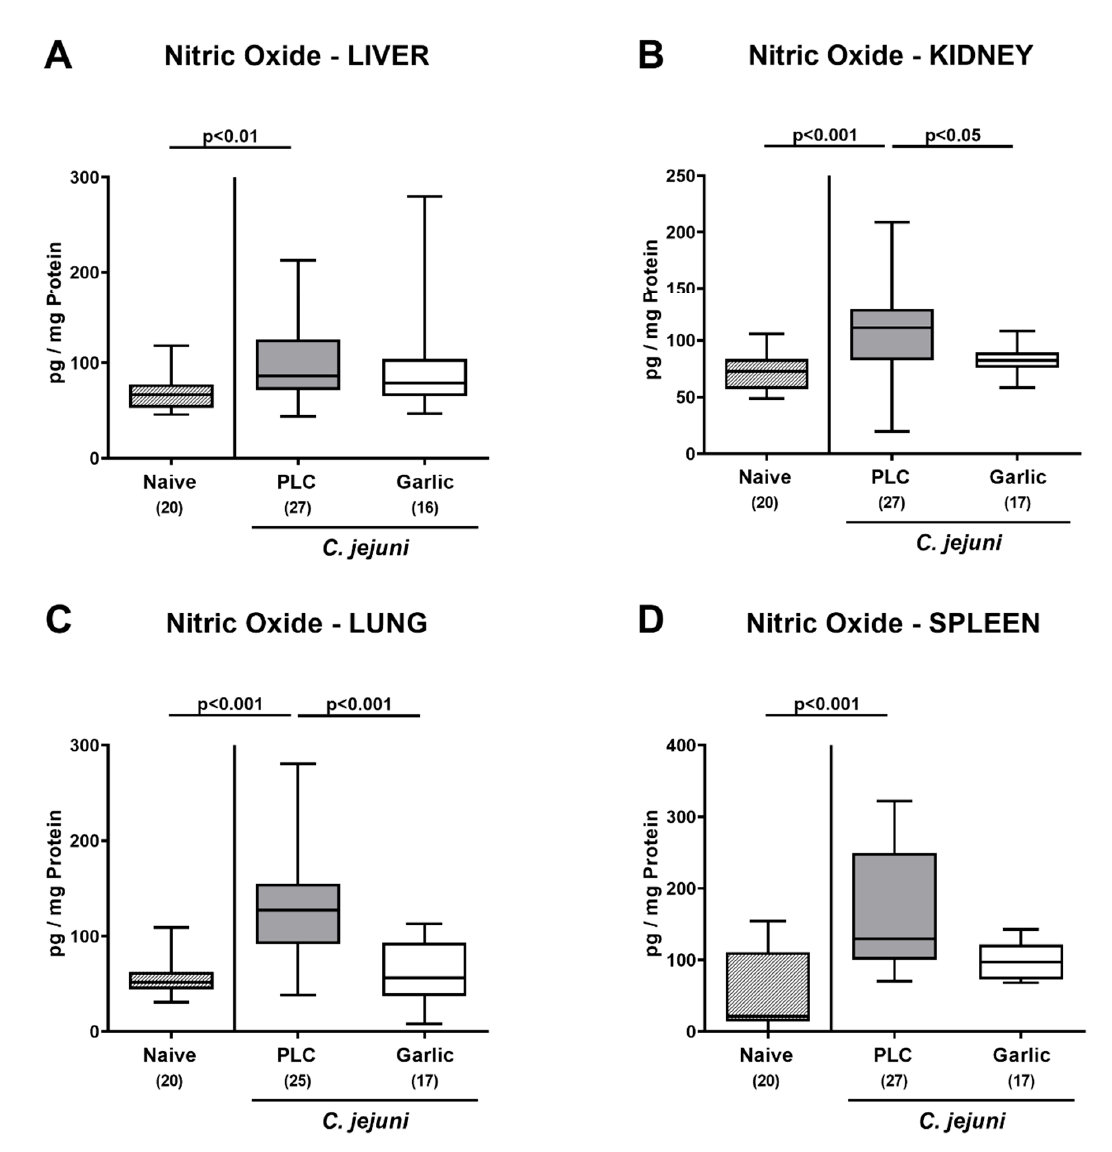
Figure 8. Extra-intestinal nitric oxide secretion upon garlic essential oil treatment of C. jejuni infected IL-10 -/- mice. Second- ary abiotic IL-10 -/- mice were orally challenged with C. jejuni strain 81-176 on days 0 and 1 followed by treatment with either garlic essential oil (white boxes) or placebo (PLC, gray boxes) via the drinking water starting on day 2 post-infection. Nitric oxide concentrations were determined in culture supernatants of explants taken from the ( A ) liver, ( B ) kidney, ( C ) lung and ( D ) spleen on day 6 post-infection. Naive mice (hatched boxes) served as non-infected and untreated cohort. Box plots (indicating the 25th and the 75th percentiles), whiskers (indicating maximum and minimum values), medians (black bar inside box), significance levels ( p values) determined by the Kruskal-Wallis test and Dunn’s post-correction and the total number of mice (in parentheses) are shown (pooled data from four independent experiments).